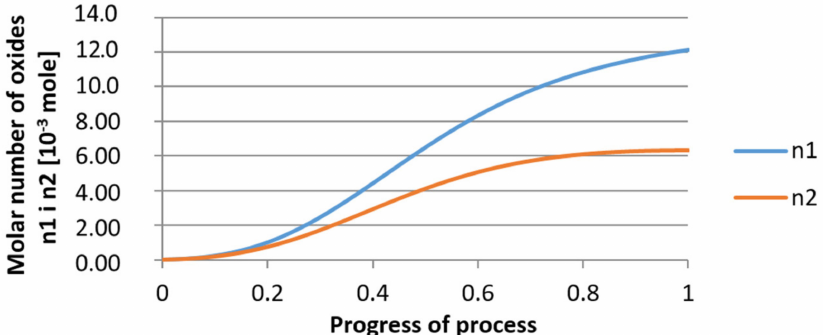
Figure 24. Growth of bi-component nuclei of oxides n 1 (Al 2 O 3 ) and n 2 (Y 2 O 3 ) in steel 2 (for r 0 = 5 µ m).